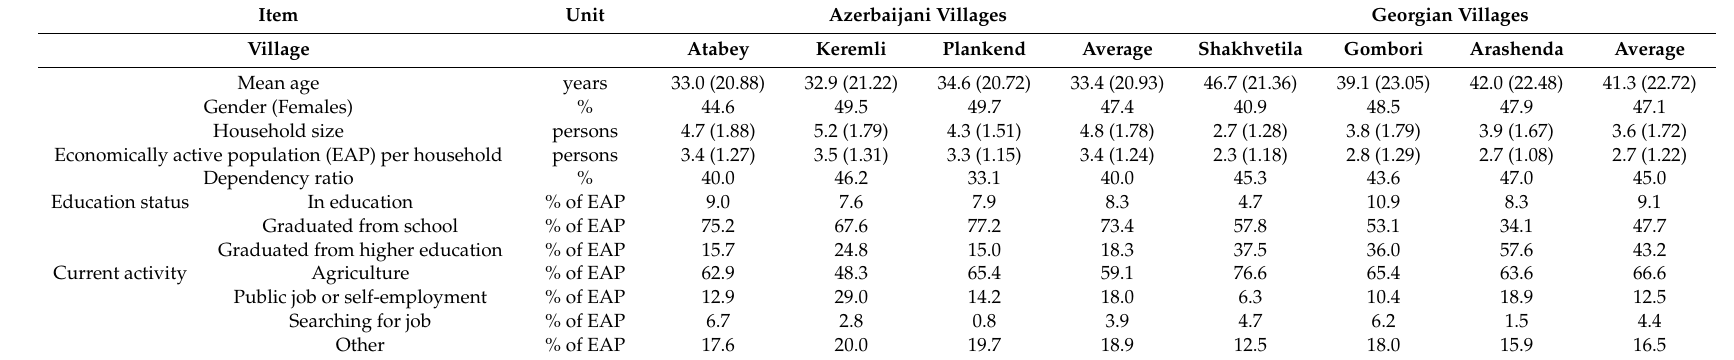
Table 2. Demographic information on the surveyed